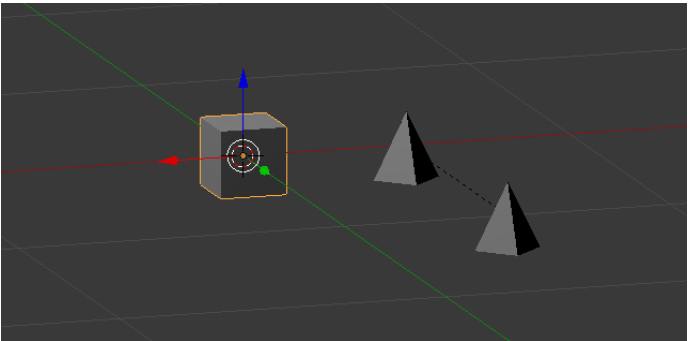
Figure 2. “Accelerometer” (left) and “Rope” gadgets (right).